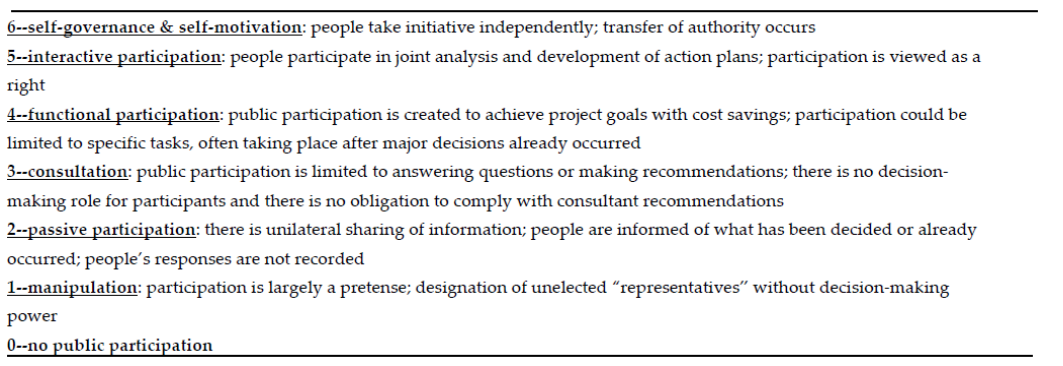
Figure 3. Typology of participation [8]. Modified with permission from J. Pretty, World Development ; published by Elsevier, 1995.